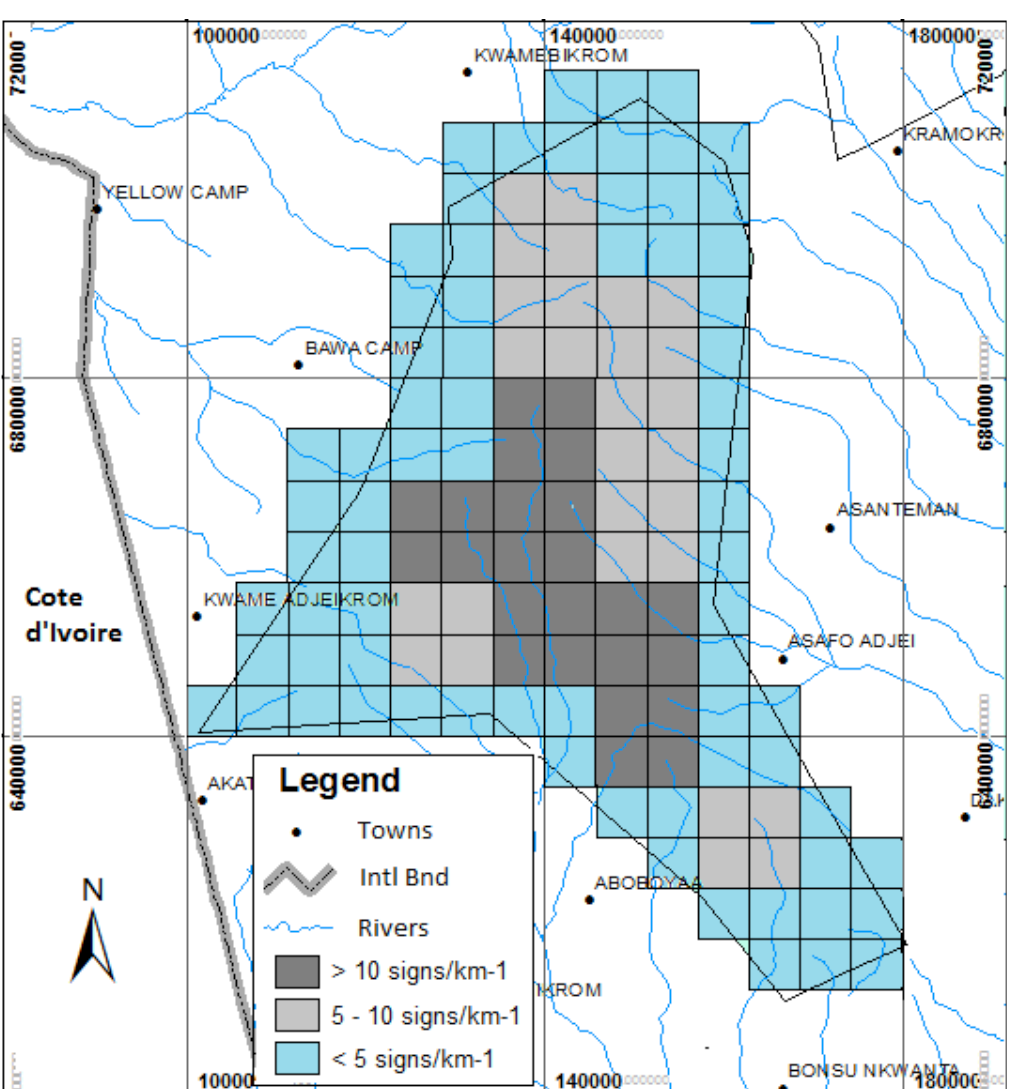
Figure 3. BCA showing distribution and intensity of elephant activities